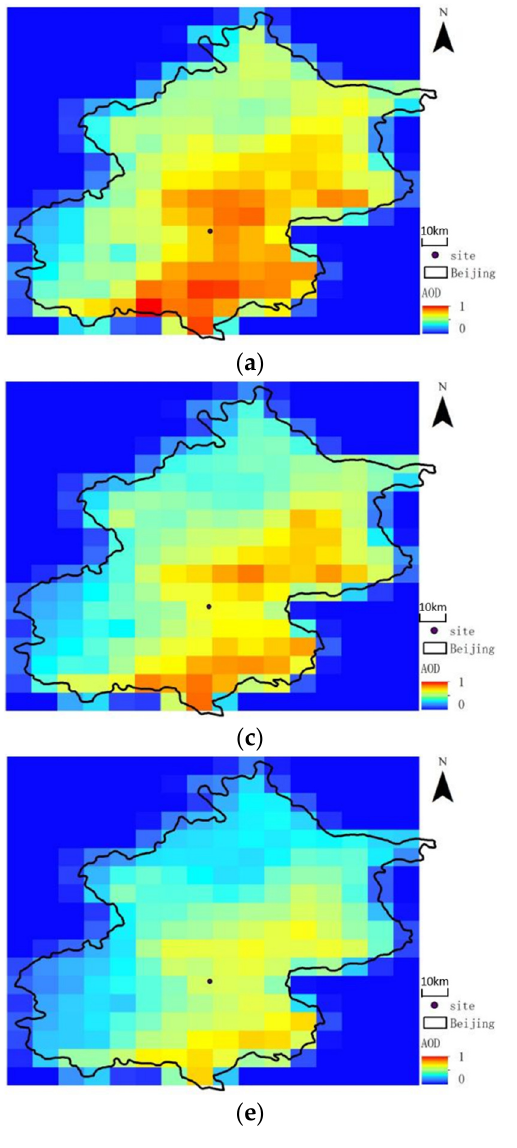
Figure 7. The distribution of AOD (412 nm) in Beijing from 2015 to 2020 ( a – f ).